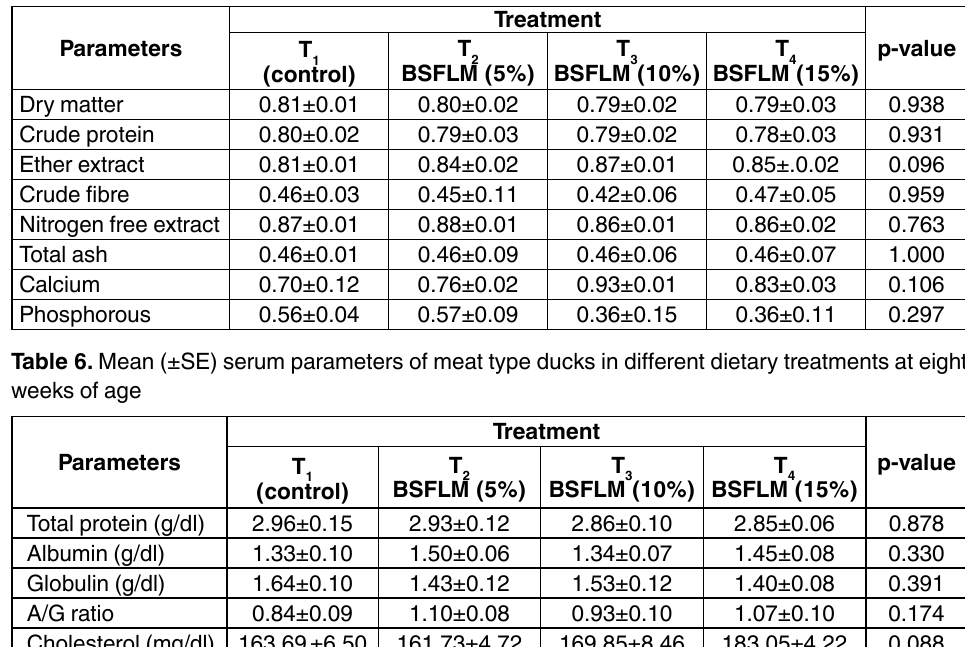
Table 5. Mean (± SE) nutrients digestibility of meat type male ducks in different dietary treatments, co-efficient